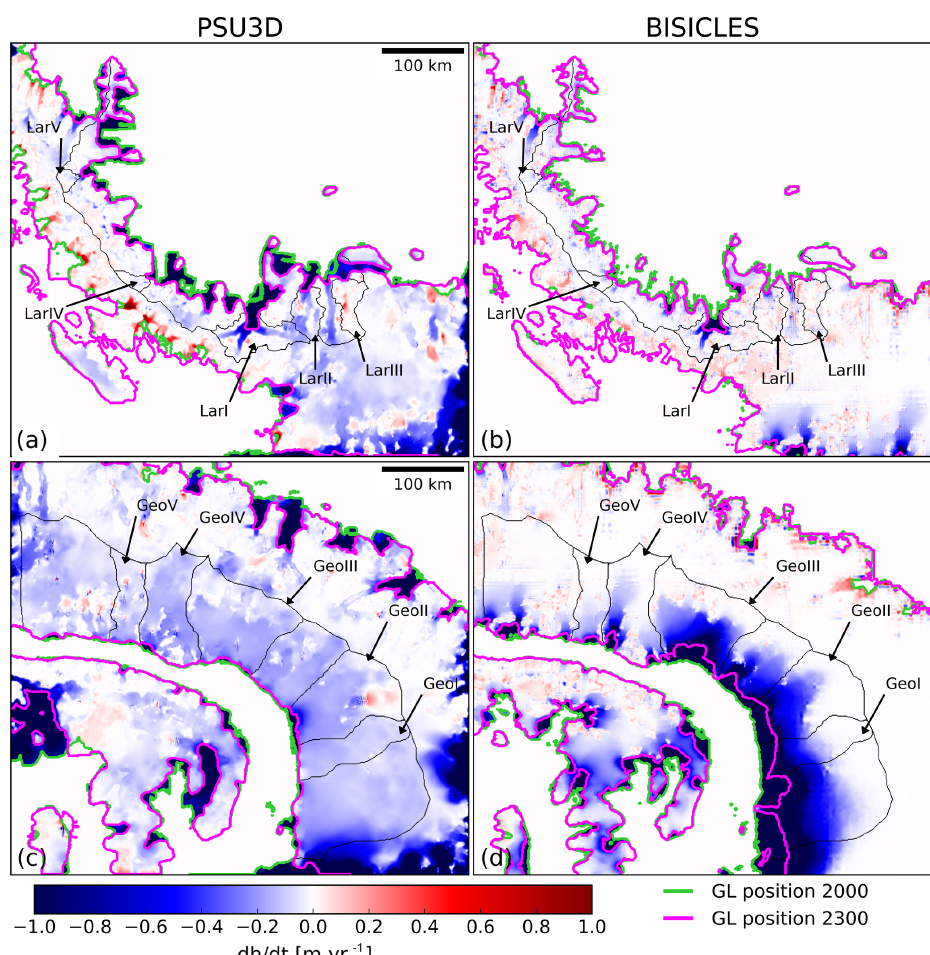
Figure 8. Dynamic thinning (d h/ d t pattern from Experiment 2 (dynamic calving front) averaged over the simulation period 2000–2300 in the RCP8.5 scenario for Larsen C (a, c) and George VI embayments (b, d) . Black lines denote modelled drainage basins. LarI–LarV and GeoI–GeoV indicate drainage basins selected for